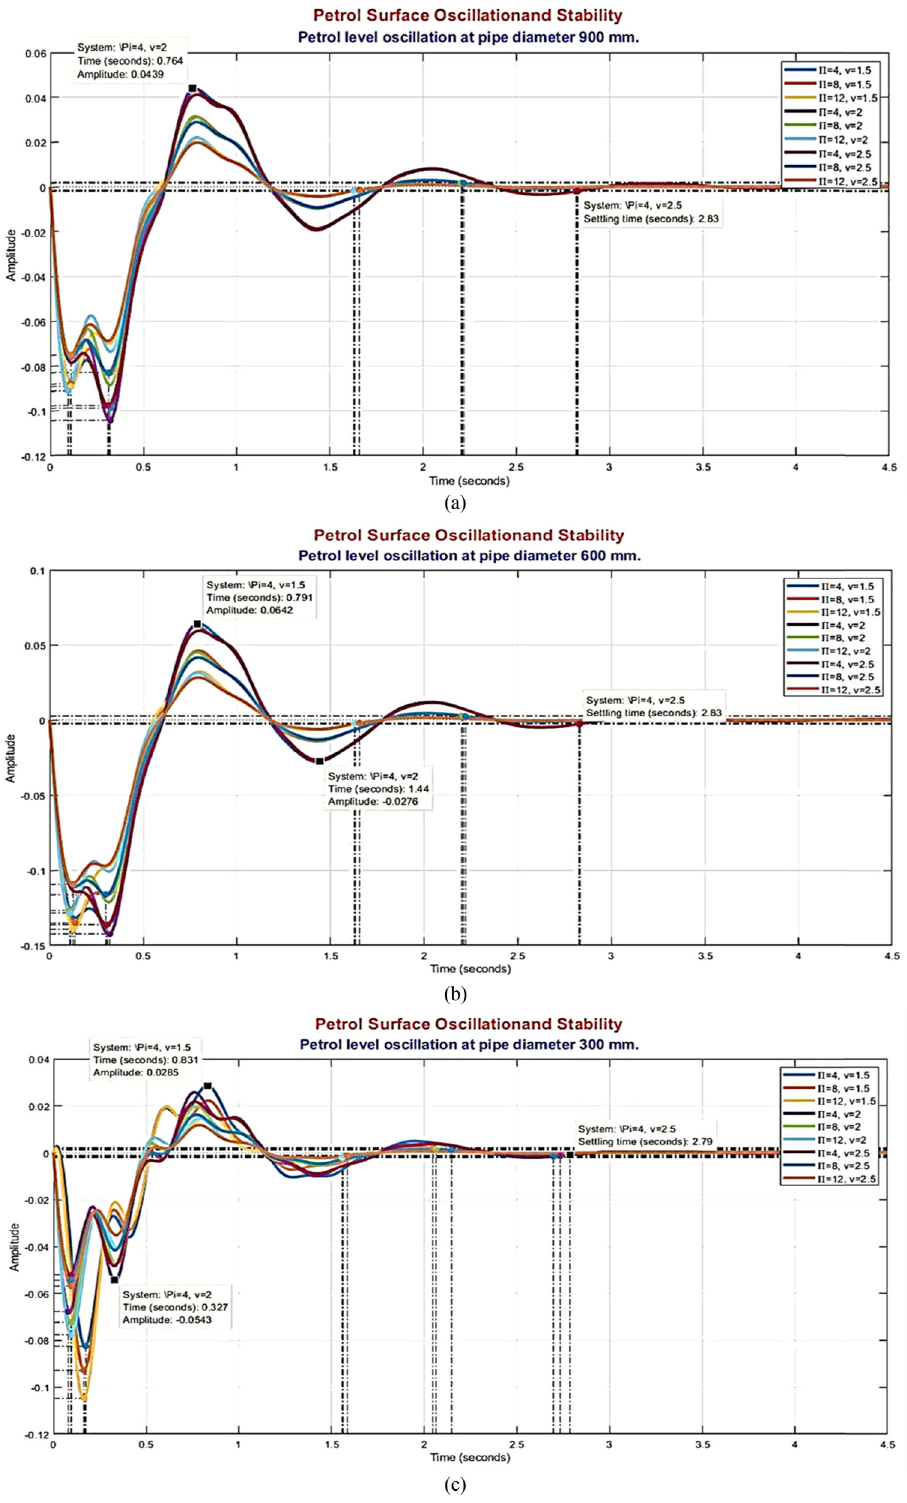
Figure 3: System stability with di ff erent pressure and fl ow rate e ff ects, for petrol fl uid types with di ff erent pipe diameters. ( a ) Pipe diameter 900 mm. ( b ) Pipe diameter 600 mm. ( c ) Pipe diameter 300